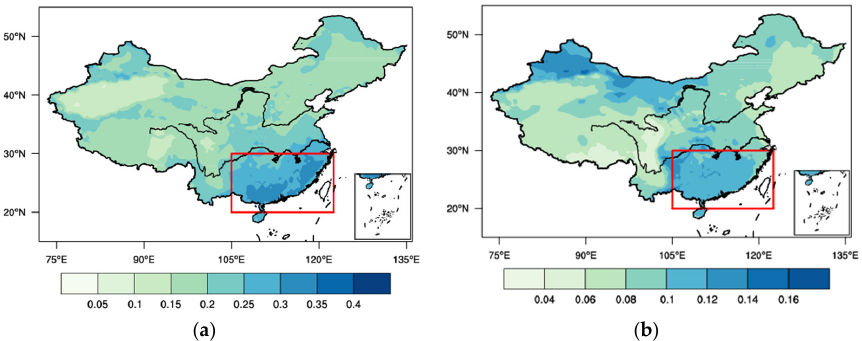
Figure 4. Ratio of 10–30-d filtered T min variance ( a ) and 30–60-d filtered T min variance ( b ) to 1979–2019 mean winter T min variance spatial distribution. (The red box shows the southern region (20°–30° N, 105°–122.5° E)